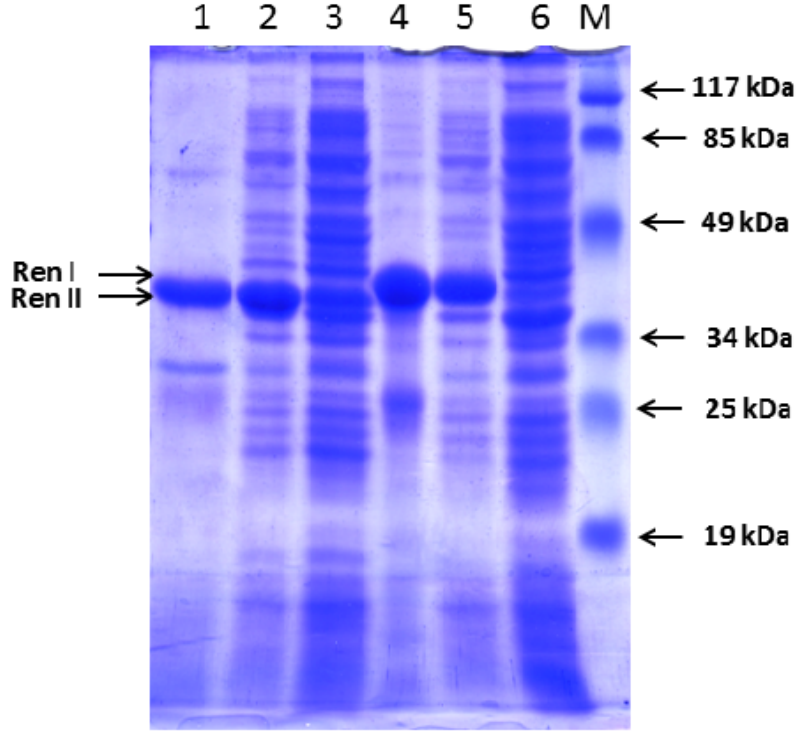
Figure 5. Expression of hRenalase1 and hRenalase2 in E. coli cells. Sodium dodecyl sulfate-polyacrylamide gel electrophoresis (SDS-PAGE) analysis of expression of polyHis hRenalase1 (RenI—39 kDa) and hRenalase2 (RenII—36 kDa) in E. coli Rosetta (DE3) cells transformed by pET-hRenI and pET-hRenII vectors. Tracks 1 and 4—polyHis hRenalase2 (RenII—36 kDa) and hRenalase1 (RenI—39 kDa), respectively, purified on Ni-Sepharose; Tracks 2 and 5—lysates of cells transformed pET-hRenI и pET-hRenII induced with 1.0 mM IPTG; Tracks 3 and 6—lysates of cells transformed pET-hRenI and pET-hRenII, without IPTG; Track M—molecular mass markers. Mass values are shown on the